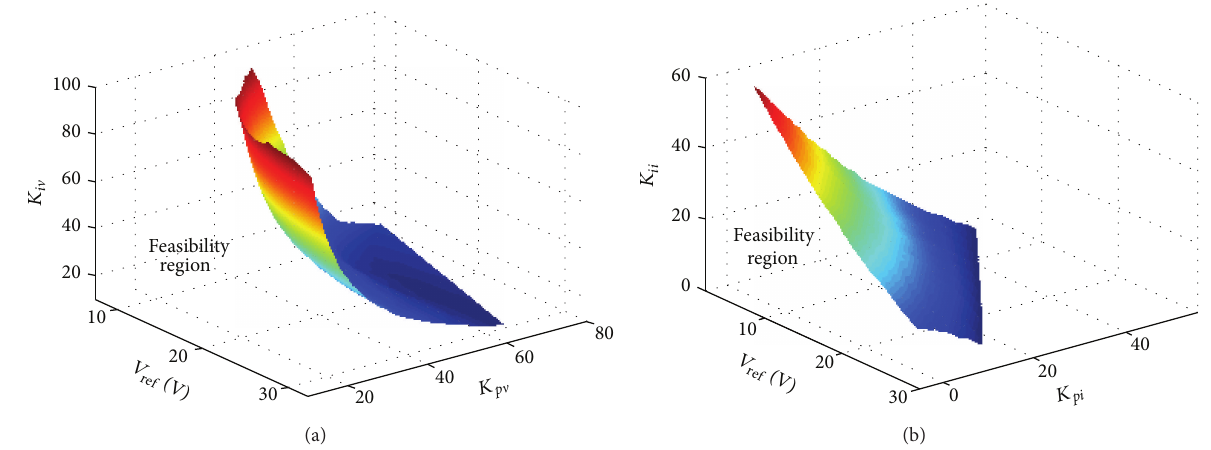
Figure 14: Feasibility regions of key parameters, (a) 𝑉 = 49 . 𝐾 𝑖 V